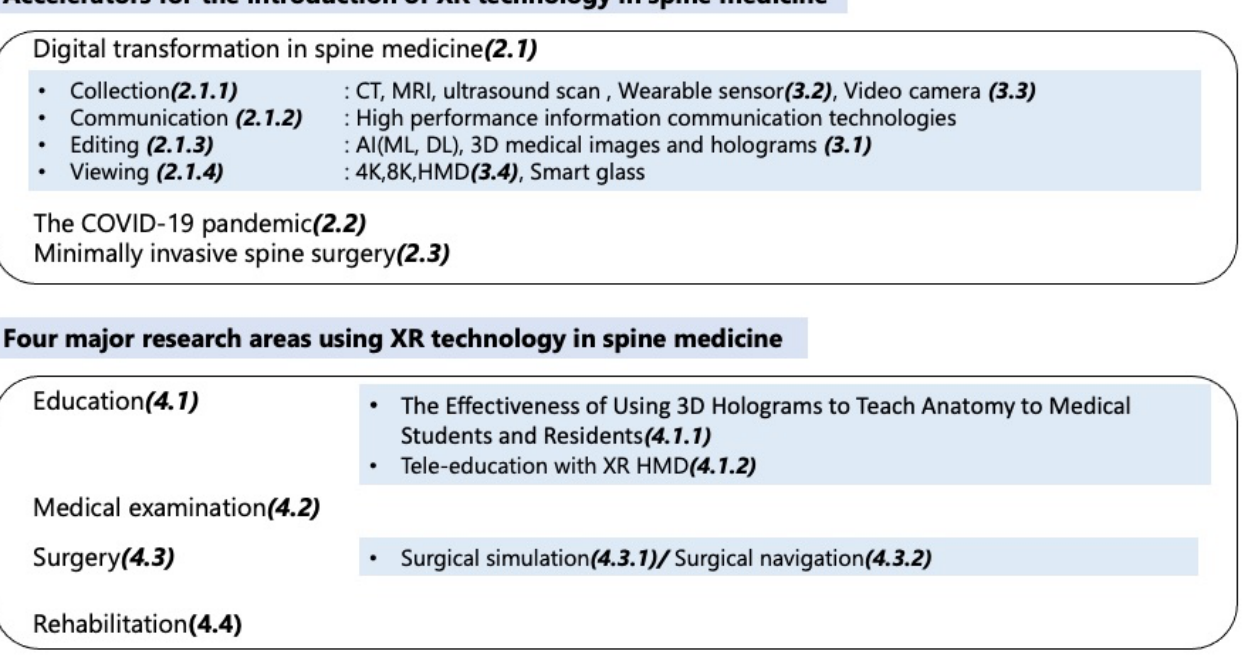
Figure 1. XR technology in spine medicine in contents of this manuscript. XR, extended reality; AI, artificial intelligence; ML, machine learning; DL, deep learning; HMD, head mounted display.